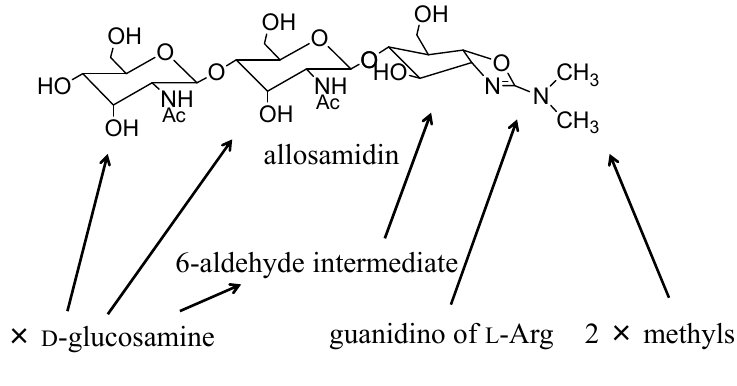
Figure 2. Structures of natural